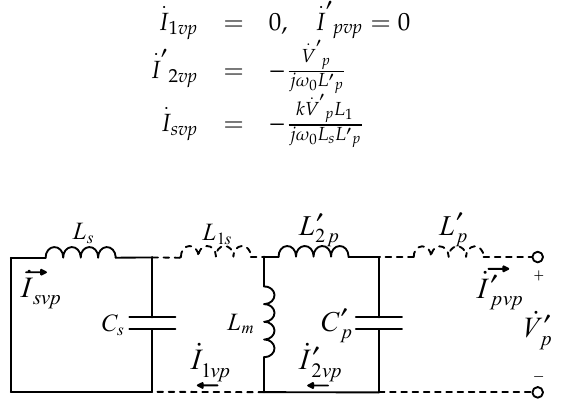
(cid:48) . V V ′  only. Figure 8. Circuit state of a resonant network acted on by p p